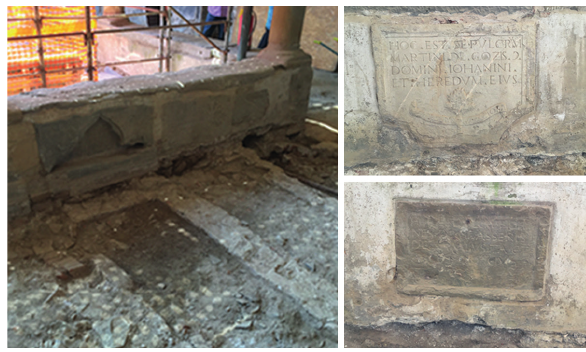
Figure 4. Details of the burial-epigraph system